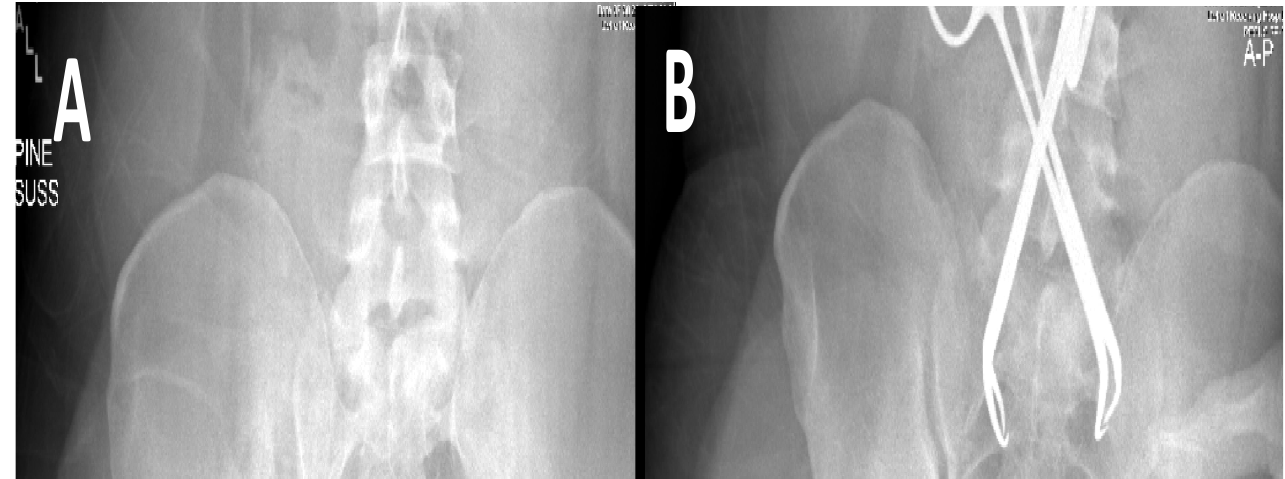
Figure 2. Both commercial binders and traditional sheeting techniques seem to be effective at reducing pelvic volume. A: Before